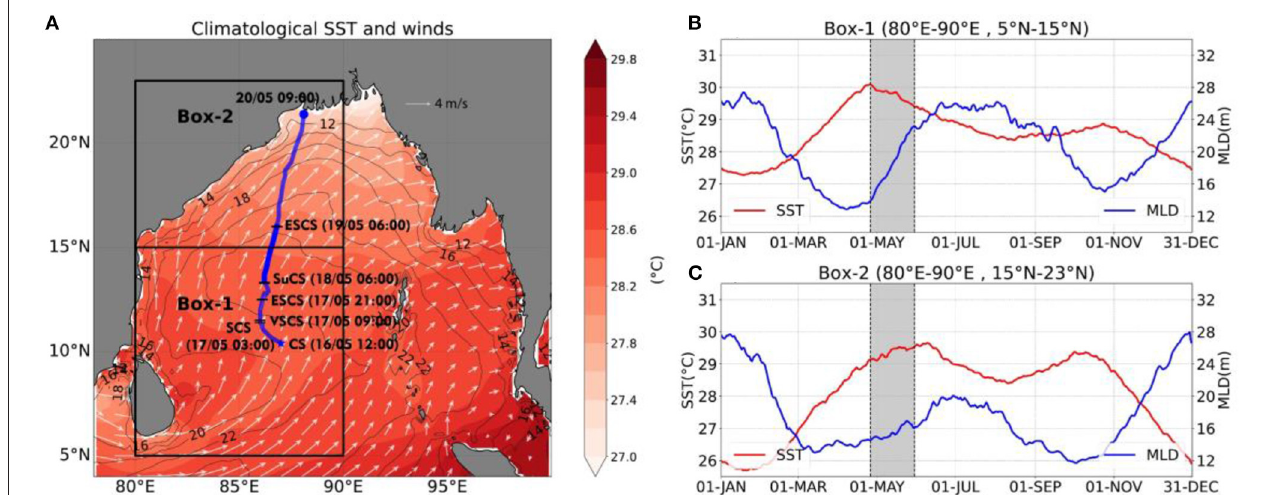
FIGURE 1 | (A) Study region of the Bay of Bengal (70–100 ◦ E and 0–25 ◦ N) delineated by the boxes for the subregions of the bay i.e., box 1 (80–90 ◦ E and 5–15 ◦ N), box 2 (80–90 ◦ E and 15–23 ◦ N) with annual mean sea surface temperature ( ◦ C, shaded), overlaid by the contours of annual mean mixed layer depth (m) and vectors of annual mean surface winds (ms − 1 ), and the track of Tropical cyclone Amphan with the dates of cyclogenesis (CS, 16-May-2020), intensification into a super cyclonic storm (SuCS,18-May-2020), and landfall as extremely severe cyclonic storm (ESCS, 20-May-2020), (B) daily climatology for the area-averaged sea surface temperature and mixed layer depth for box 1 with gray shading indicating the time of year that is the focus of the current study (26-Apr to 30-May), (C) same as (B) but for box 2.